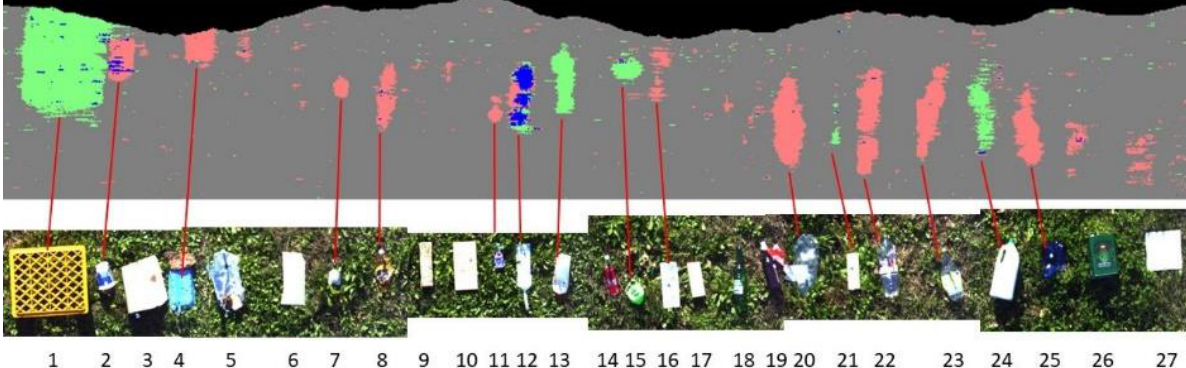
Figure 11. Detection of objects over grass: (1) Plastic crate; (2) PET container; (3) cardboard; (4) PS tray; (5) aluminum foil; (6) floor tile; (7) PET container; (8) PET bottle; (9) brick; (10) wood; (11) PET container; (12) HDPE bottle; (13) PET bottle; (14) metal can; (15) plastic thread; (16) PET tray; (17) wood; (18) and (19) glass bottles; (20) PET bottle; (21) Styrofoam floater; (22) and (23) PET bottles; (24) HDPE bottle; (25) PET bottle; (26) iron container (with pasted label); (27) floor tile. Color codes as in Figure 10.